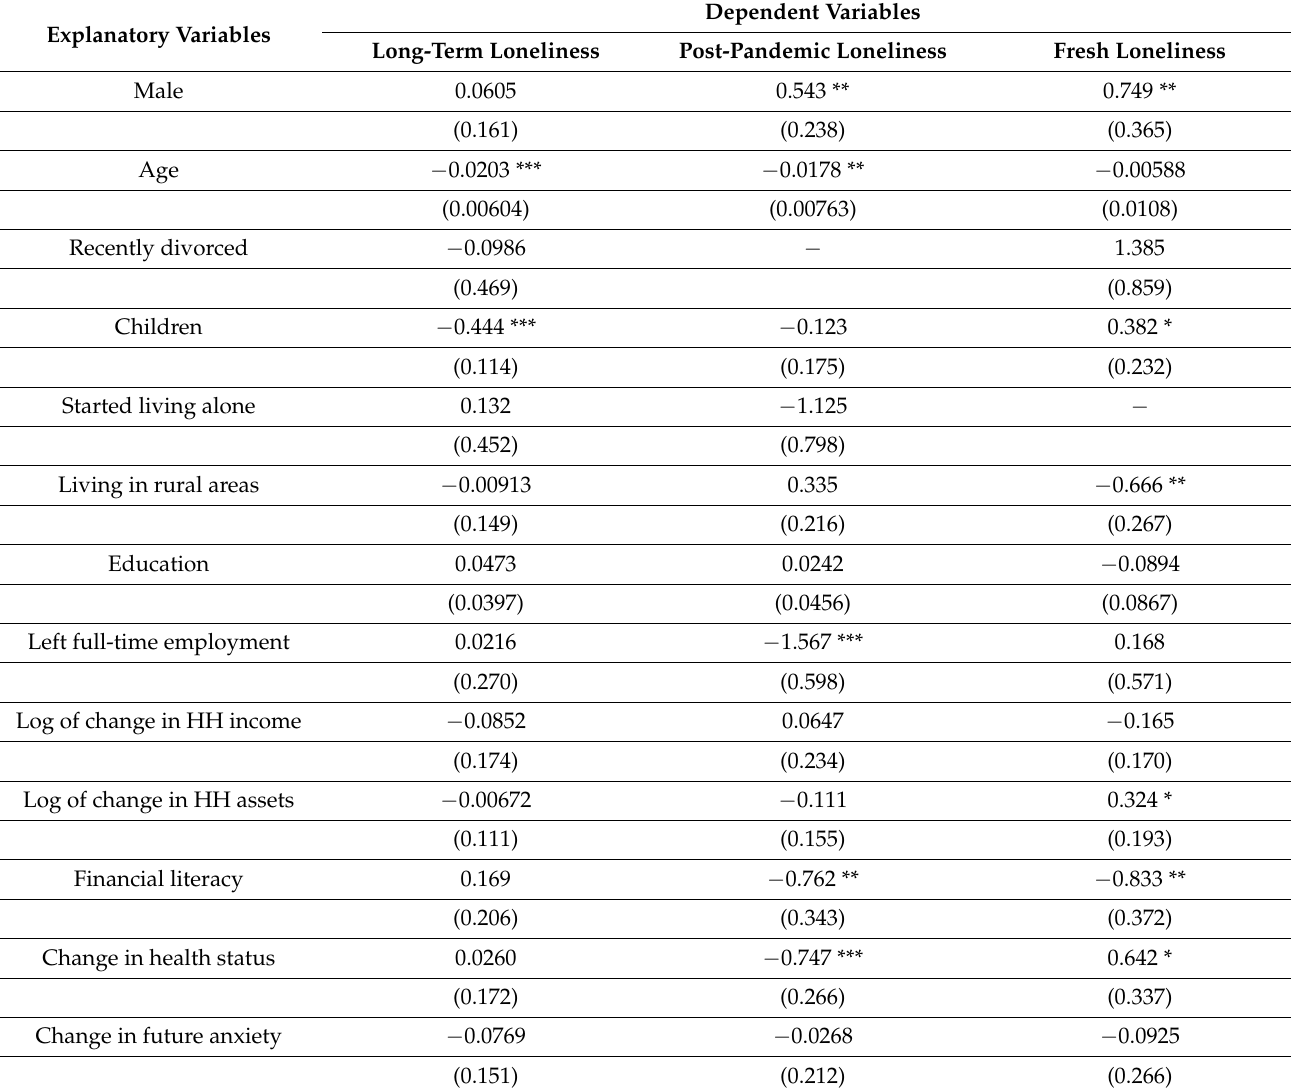
Table 6. Regression results for long-term, post-pandemic, and fresh